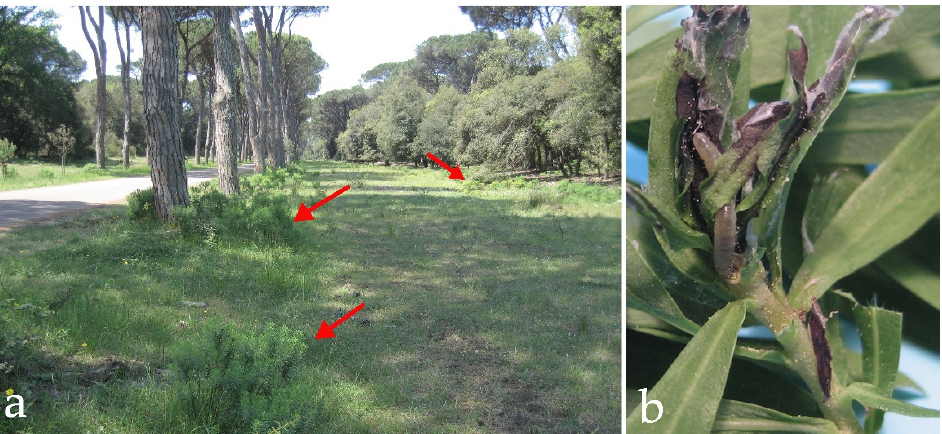
Figure 2. ( a ) Daphne gnidium shrubs (arrows) in the Regional Reserve of Migliarino, San Rossore, Massaciuccoli (Tuscany, Central Italy). ( b ) Nest of Lobesia botrana on a D. gnidium sprout.